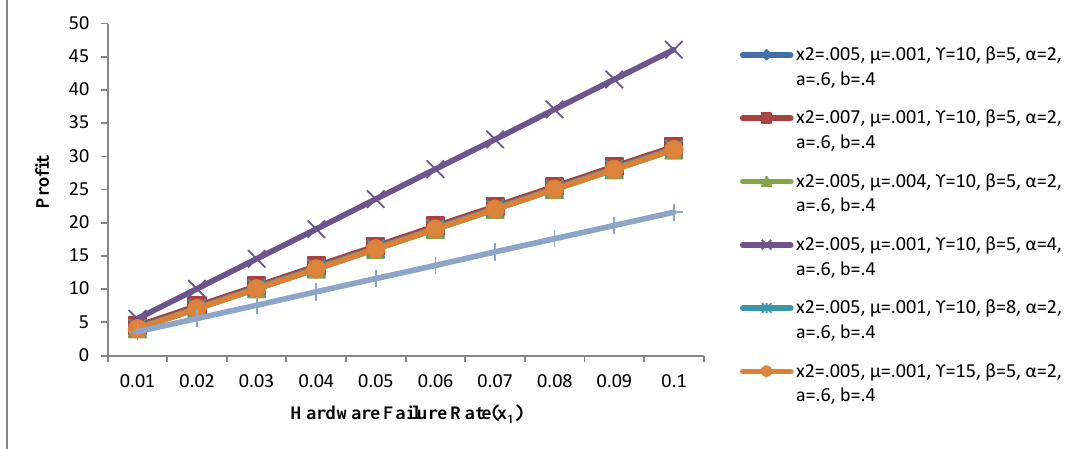
Figure 6. Profit (P 1 -P 2 ) vs hardware failure rate ( 𝑥